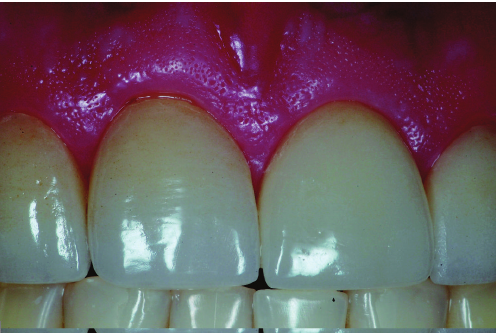
Figure 12: Final aspect after laminate veneers and all-ceramic crowns cementation.